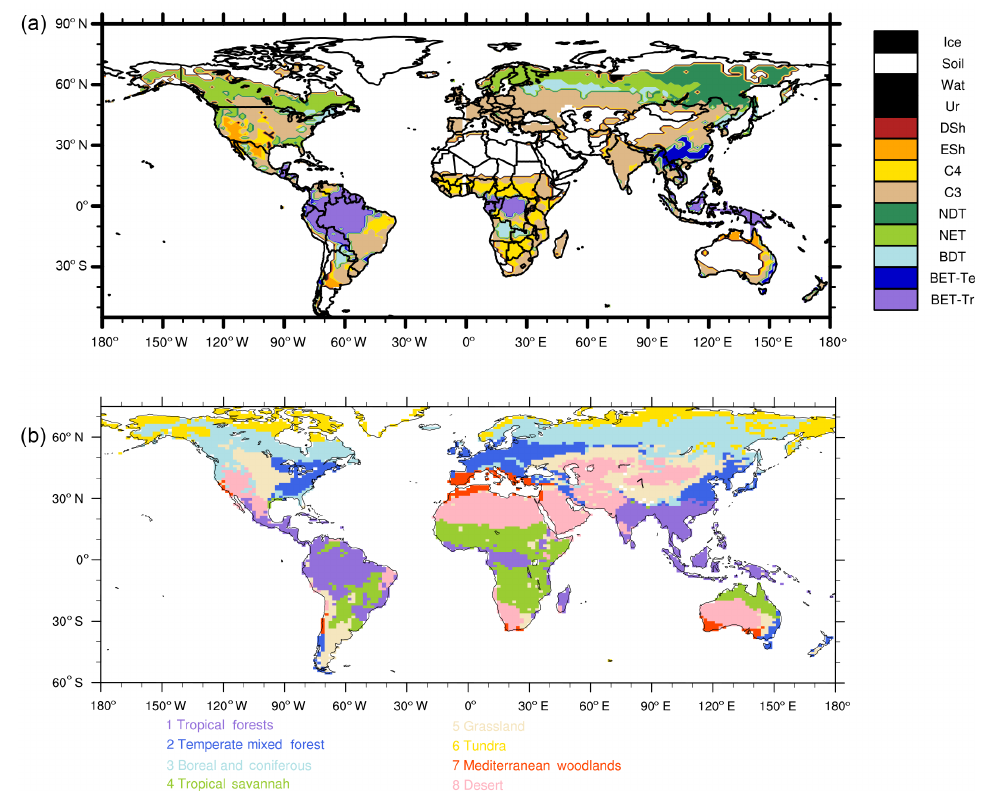
Figure 3. (a) Dominant vegetation type from the ESA LC_CCI data set, aggregated to the new nine PFTs. (b) Color-coded map of global biomes, based on World Wildlife Fund